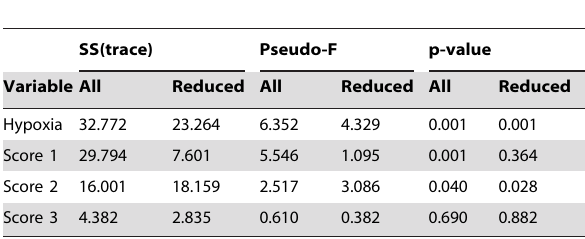
Table 2. Marginal test results from distance-based linear models (DISTLM) for variables predicting ecosystem